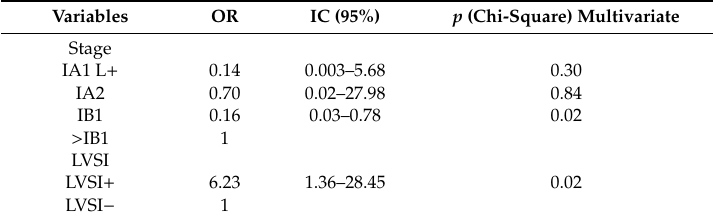
Table 3. Multivariate analysis of the factors associated with the presence of low-volume metastasis.